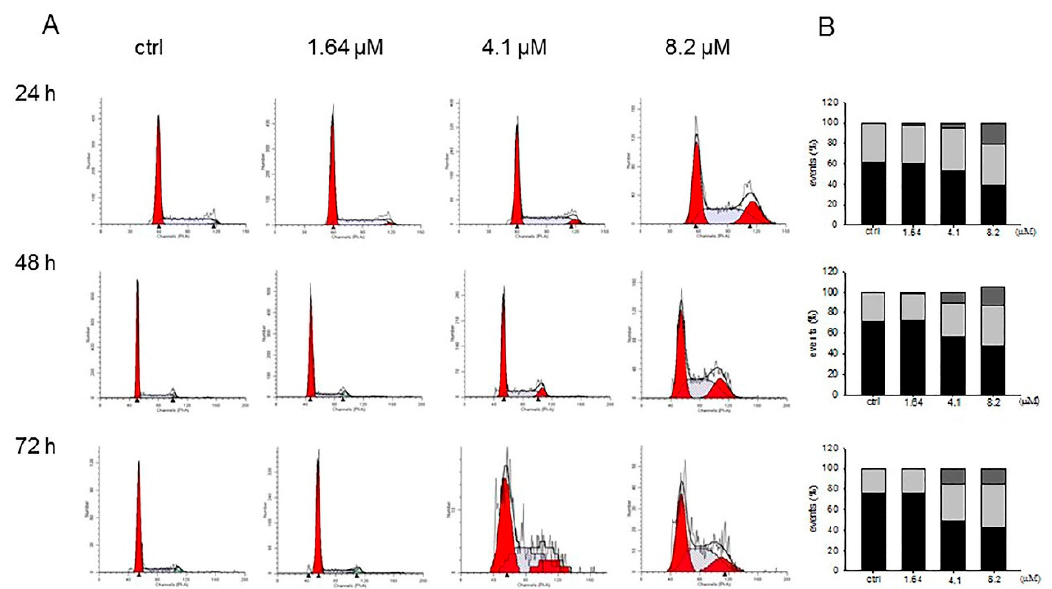
Figure 5. Influence of moringin on cell cycle distribution in SH-SY5Y cells. Progression of SH-SY5Y cells through the cell cycle was examined by flow cytometry analysis after exposure to moringin for 24–72 h ( A ). The histograms on the right ( B ) represent the percentage of events in G1 (black bar), G2 (grey), and S (light grey) phases and are the mean ± SEM of three independent experiments.